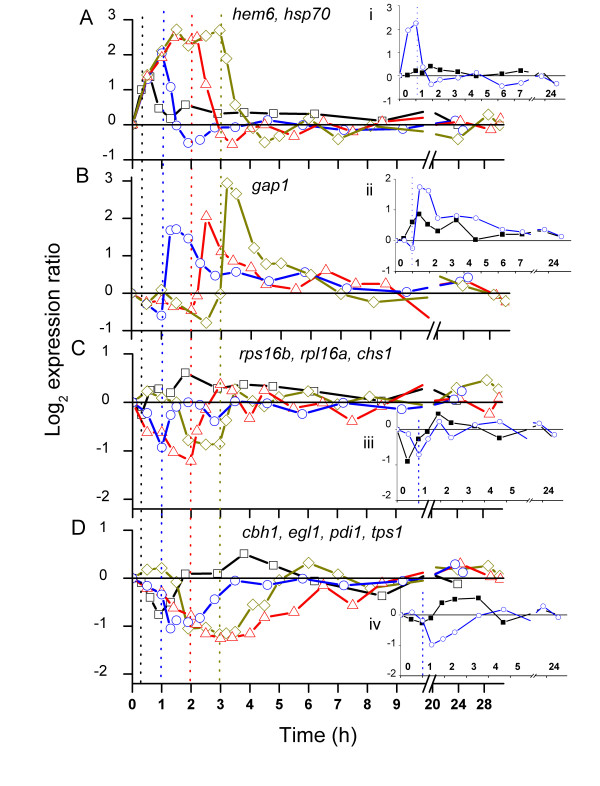
Expression of specific marker genes in T. reesei during transient anaerobic phases. Duration of anaerobic phases were 20 (black squares), 60 (blue circles), 120 (red triangles) and 180 (green diamonds) min. 0 min indicates the start of the anaerobic phase and the coloured dotted line the end of an anaerobic phase. A-D shows the average log2 expression ratios from the 0 min for different genes that showed similar responses during the experiment, subfigures i-iv show the average responses of the corresponding genes during 60 min without either medium or air feed (blue circles) or without medium feed (black squares).